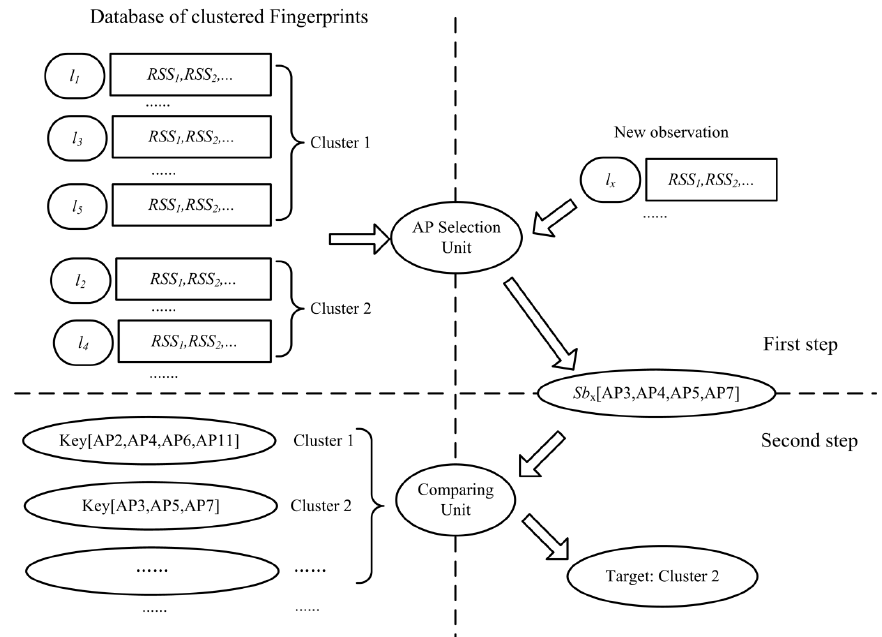
Figure 3. Process of determining the target cluster in the online stage.